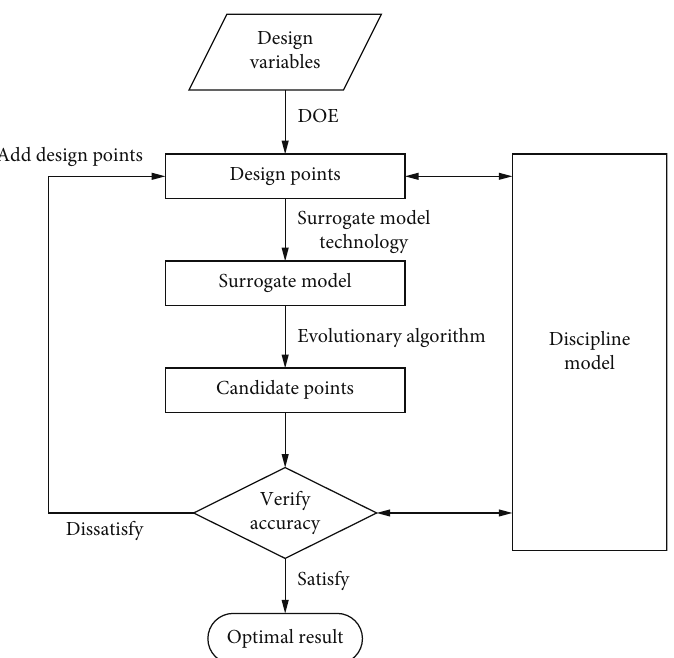
Figure 11: Surrogate model framework.